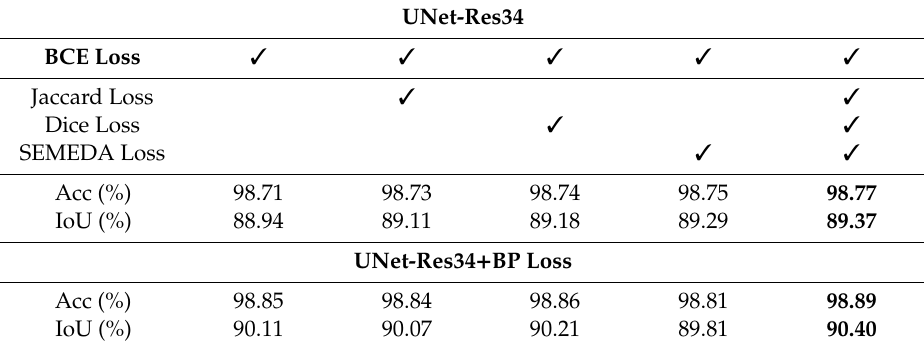
Table 3. IoU on the WHU dataset with UNet-Res34 trained with various loss functions.